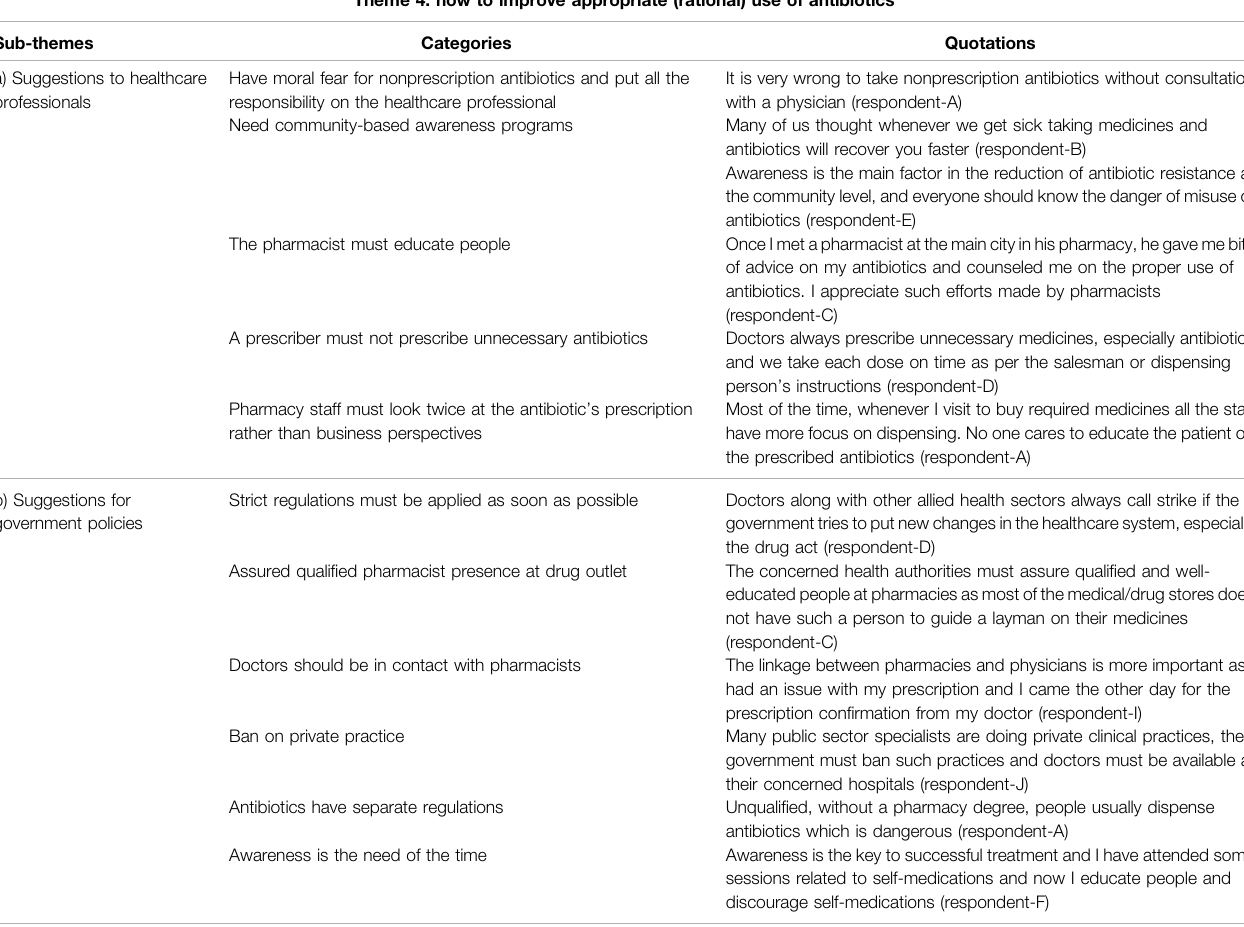
TABLE 6 | Suggestions for the appropriate use of